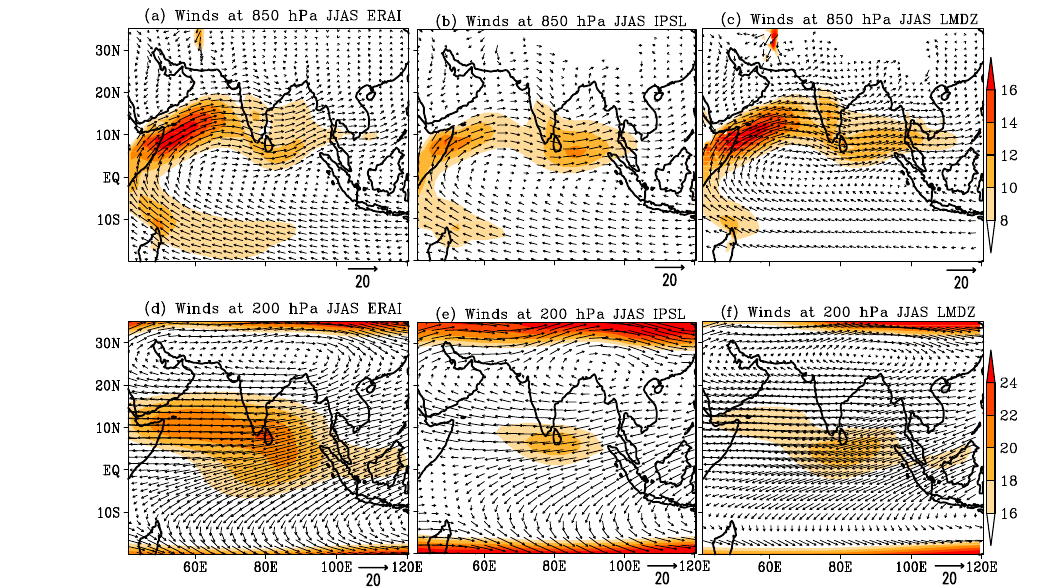
Figure 1. Spatial maps for JJAS mean wind fields (ms − 1 ) at (top) 850hPa and (bottom) 200hPa for (a, d) ERAI (1979–2005), (b, e) IPSL (1951–2005) and (c, f) LMDZ (1951–2005) simulations. Shading denotes wind